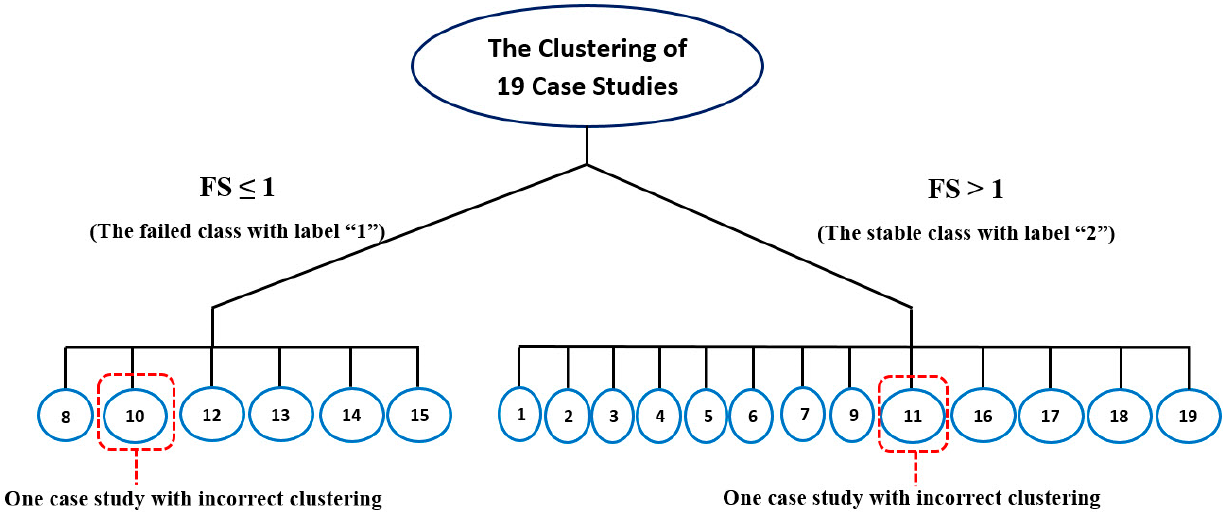
Figure 5. Results of clustering with two classes by the HS algorithm.